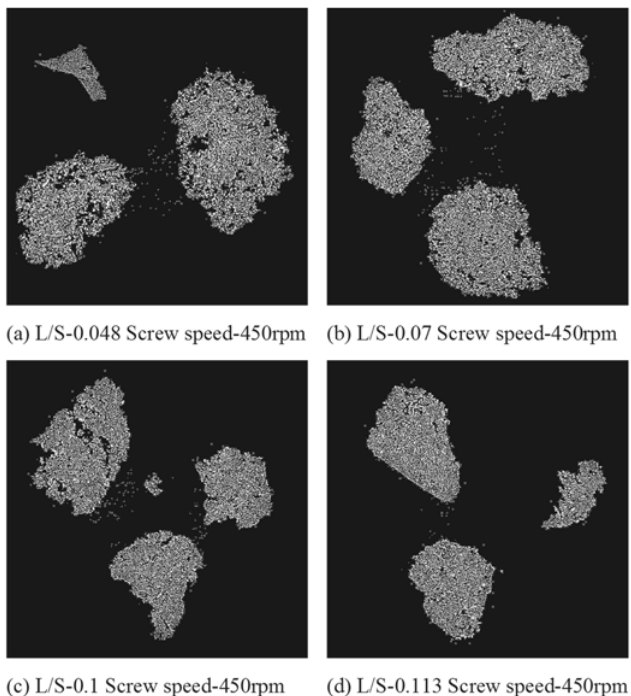
Figure 7. X ‐ ray tomographic images of granules produced using Pharmatose 200M at varying L/S (screw speed, 450 rpm).